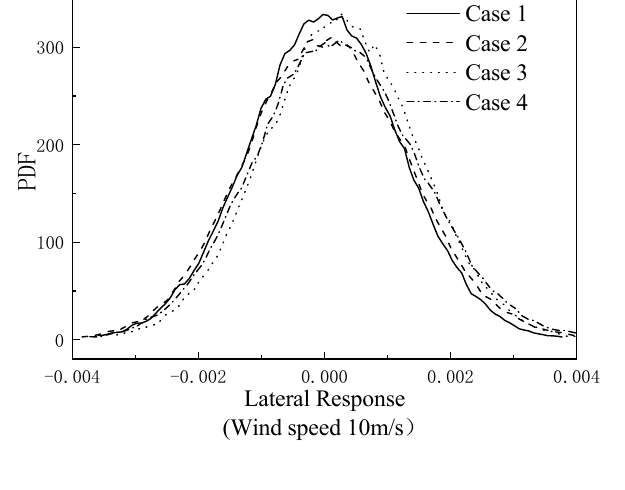
Figure 5. The PDF of the lateral stochastic responses of the bridge deck.